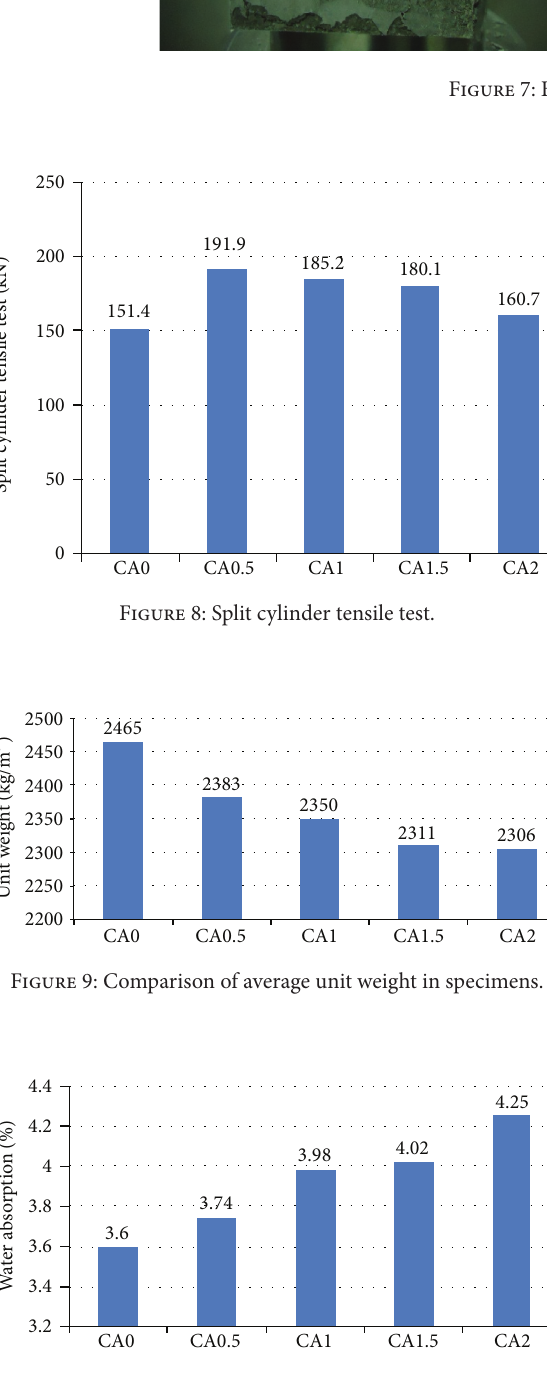
Figure 10: Comparison of water absorption in samples.